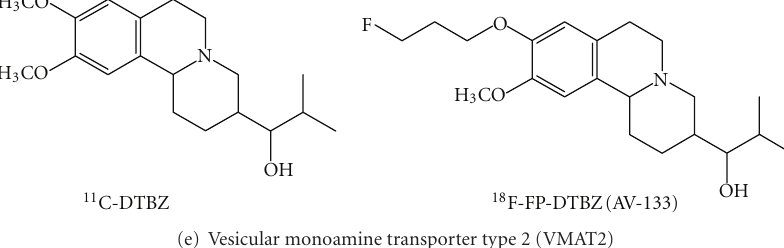
Figure 1: Chemical structure of various radiotracers for the assessment of dopamine synthesis, reuptake sites, and receptors.